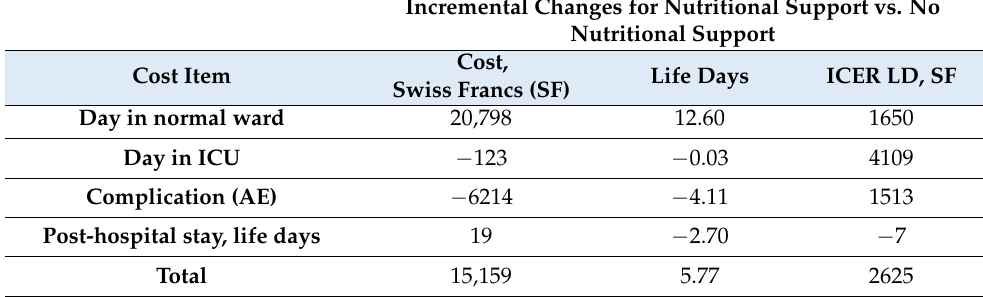
Table 3. Results for incremental differences from base-case analysis of HF patients in EFFORT. Incremental Changes for Nutritional Support vs.